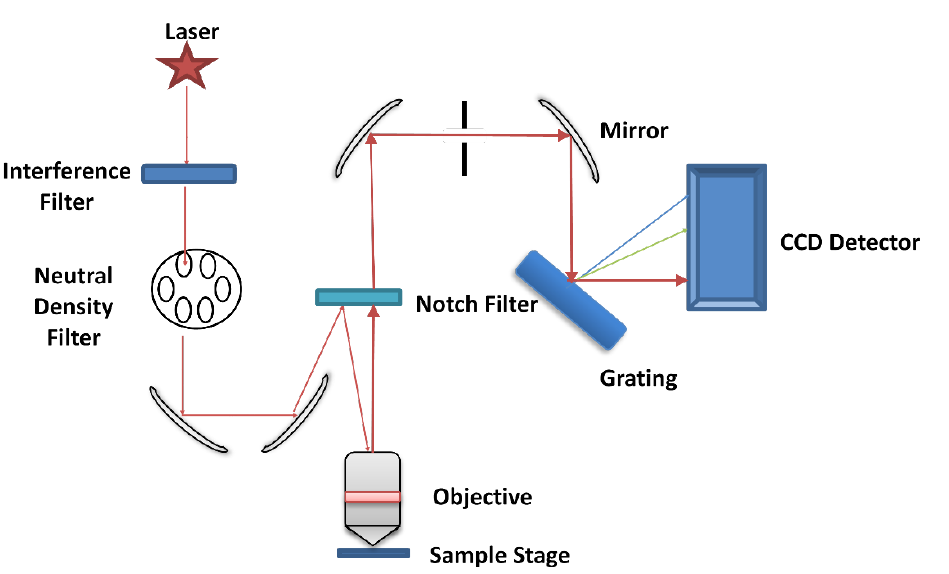
Figure 6. A schematic of a Raman microspectrometer based on the Horiba Jobin Yvon LabRAM HR 800.